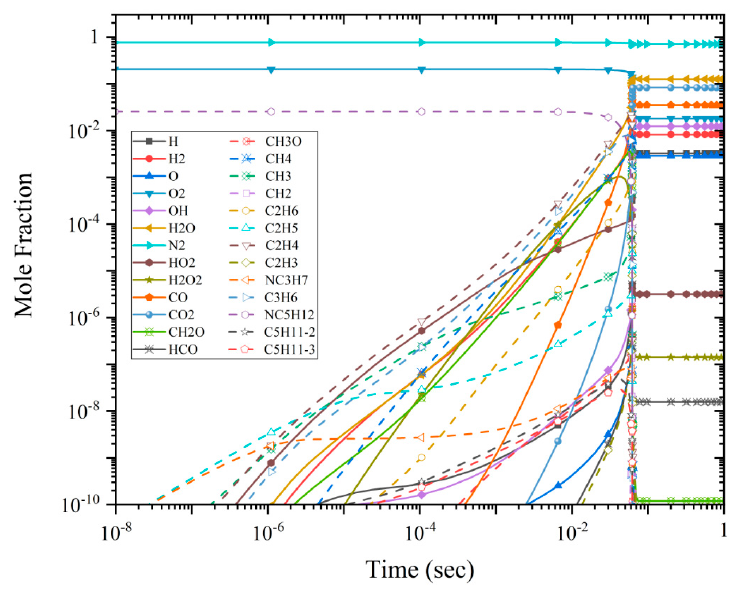
Figure 2. The changes of species calculated with DGPA at an equivalent ratio of 1.0 and a temperature of 1000 K.